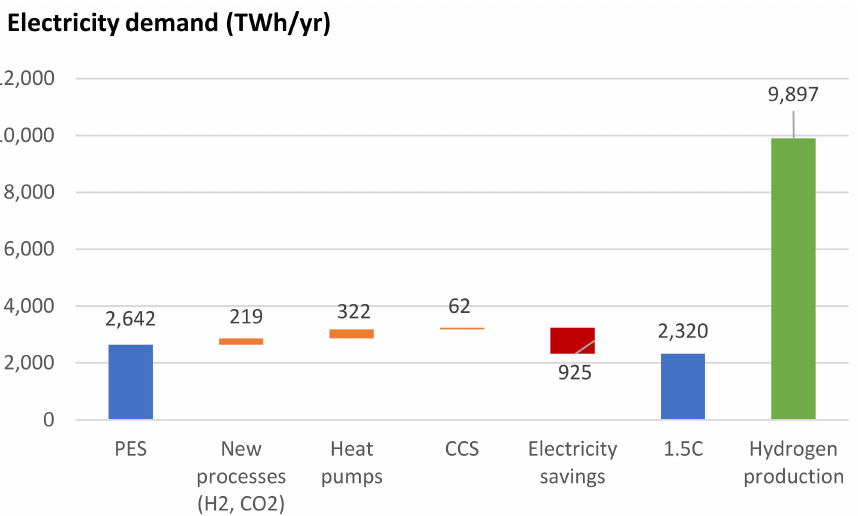
Figure 6. Changes in the estimated electricity demand in the global chemical and petrochemical sector between the PES and the 1.5 ◦ C case,